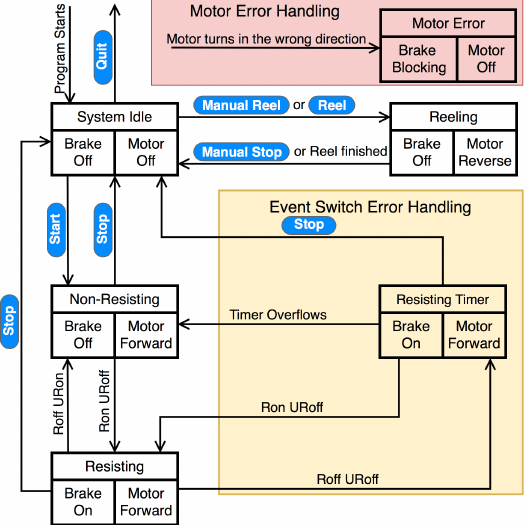
Figure 5. State-machine controller for the GPT. Each state has a name (e.g., ‘Non-Resisting’) and descriptions of the actuators (e.g., ‘Brake Off’ and ‘Motor Forward’). ‘Ron’ represents when any of the event switches on the resisted side reads ‘on’, i.e., when the resisted leg is in the stance phase. ‘Roff’ represents when all these event switches read ‘off’, i.e., when the resisted leg is in the swing phase. ‘URon’ and ‘URoff’ similarly represent the unresisted